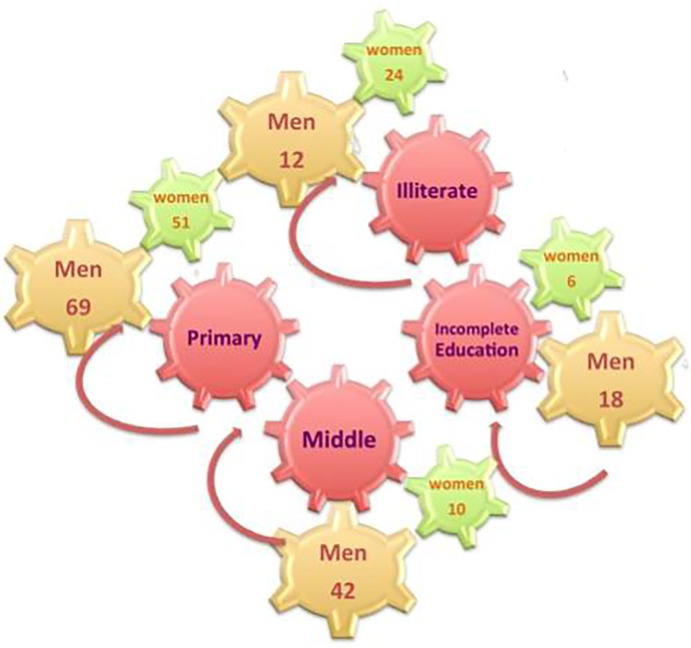
Education levels of participants.